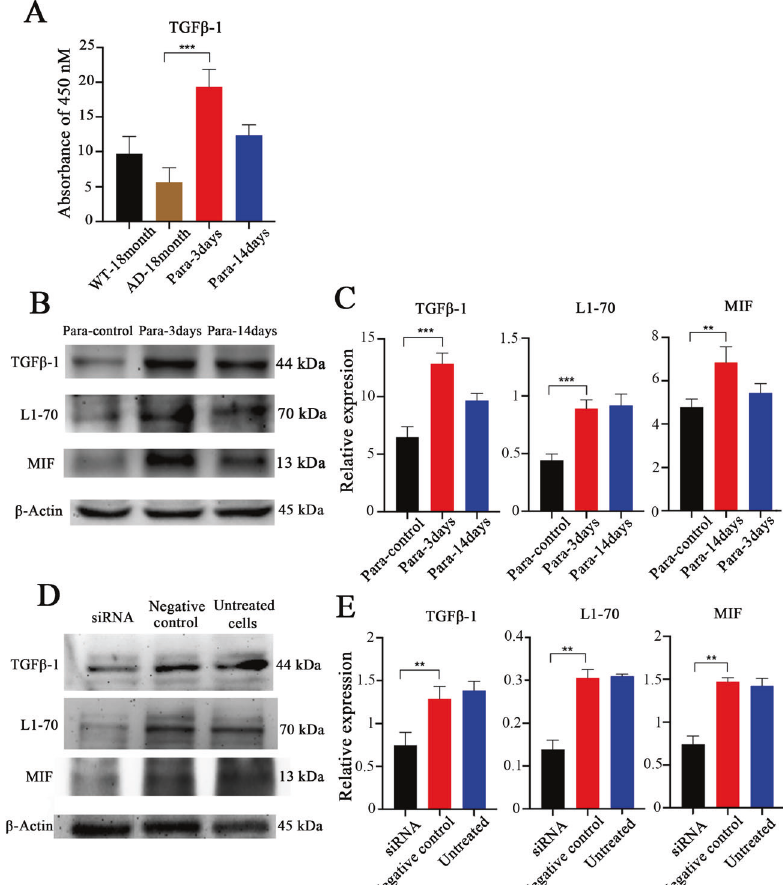
Fig. 6 Correlation of TGF β -1 expression with L1-70 and MIF expression. A ELISA analysis of TGF β -1 in the blood of aged wild-type mice, aged APPswe mice, and aged APPswe mice in parabiosis with young wild-type mice for 3 and 14 days. B Western blot analysis of hippocampal tissue homogenates from aged APPswe mice in parabiosis with aged APPswe mice, and aged APPswe mice in parabiosis with young wild-type mice for 3 days and 14 days. Antibodies against TGF β -1, L1 cytoplasmic domain, MIF, and β -actin were used for immunoblotting. C Relative to β -actin levels more TGF β -1, L1-70, and MIF are seen on day 3 and day 14 compared to the control group. The data represent means ± SD, ** p < 0.01, *** p < 0.001, one-way ANOVA with Tukey ’ s post hoc test, three independent experiments. D Western blot analysis of cell lysates of cultured N2a cells in which the expression of TGF β -1 gene was knocked down with siRNA. Antibodies against TGF β -1, L1 cytoplasmic domain, and MIF were used for immunoblotting. The expression of L1-70 and MIF decreased with the knockdown of TGF β -1. E Relative TGF β -1, L1-70, and MIF levels were calculated and normalized to β -actin. The data represent means ± SD, ** p < 0.01, *** p < 0.001, one-way ANOVA with Tukey ’ s post hoc test, three independent